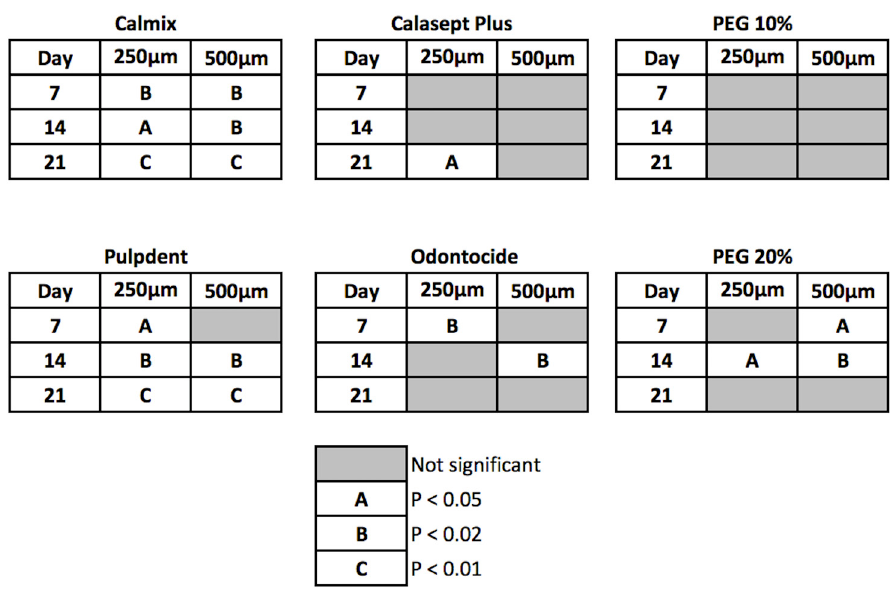
Figure 4. Visual representation of changes from the baseline in pixel data for the red and green channels. Sample areas were located at 250 and 500 μ m from the canal wall in the radicular dentine. Data are the mean of three independent experiments. Statistically significant changes, when assessed using ANOVA followed by post-hoc Dunn’s tests, are represented according to the legend.